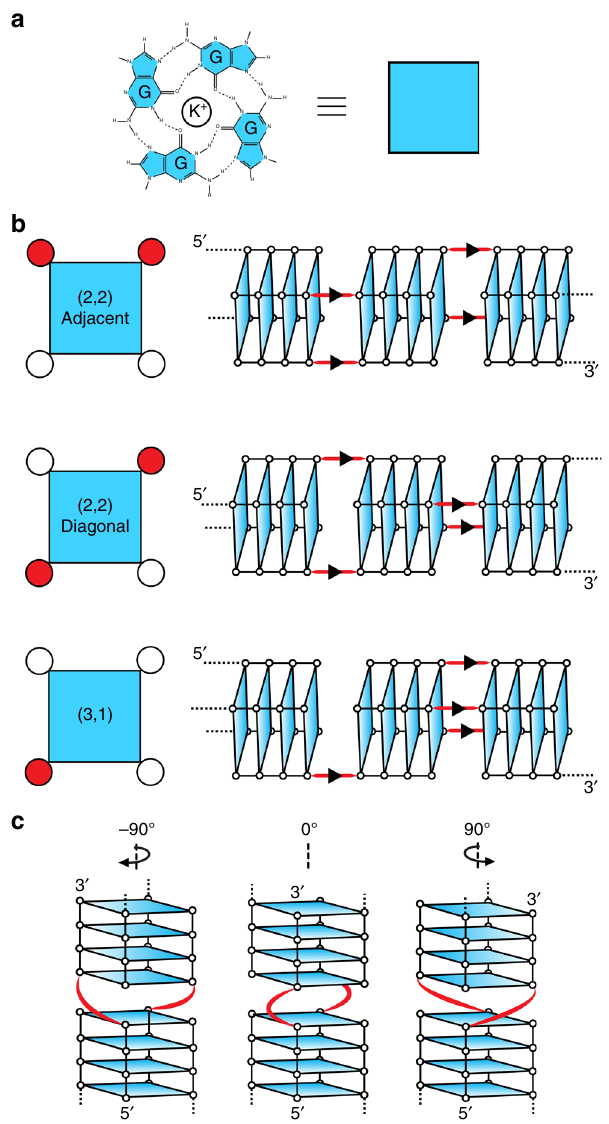
Fig. 7 Structural models of G-wires. a A G-tetrad is represented as a square for simplifying schematic representation of various G-wire models. b Three slipped-strand models: "(2,2) Adjacent", "(2,2) Diagonal" and "(3,1)" models. Left: top view of a G-tetrad; slipped strand indicated as a red dot. Right: side view of a G-wire fragment containing three G-tetrad blocks; G-tetrads are represented as planes. c Rotamers of the "(2,2) Diagonal" slipped-strand model: − 90°, 0° and + 90° rotation occurring at the TT thymine bulge (red). Rotation angle nomenclature is de fi ned by the relative rotation of the top G-tetrad block with respect to the bottom G-tetrad block and the 5 ′ → 3 ′ -strand directionality as